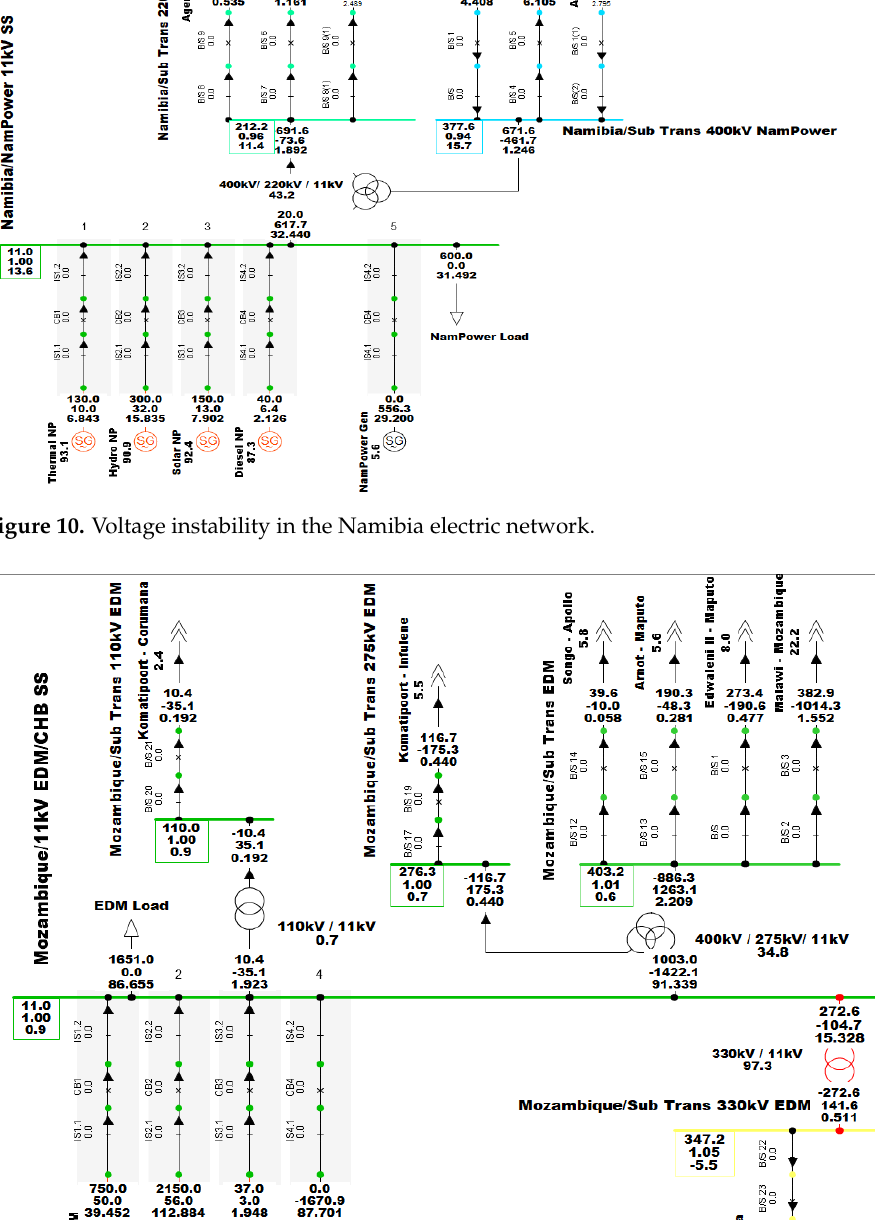
Figure 9. Southern African Region with HVdc LCC link.